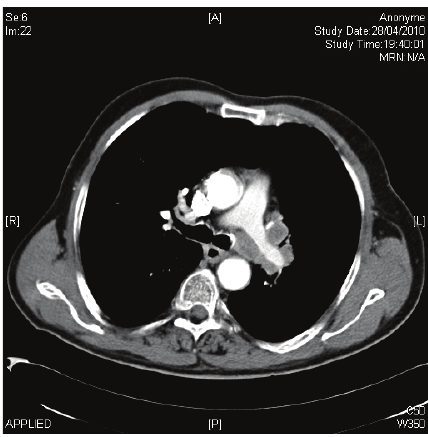
Figure 2: Magnetic resonance imaging (MRI) of the brain without ischemic changes, metastatic lesions, or abnormal enhancement with gadolinium.